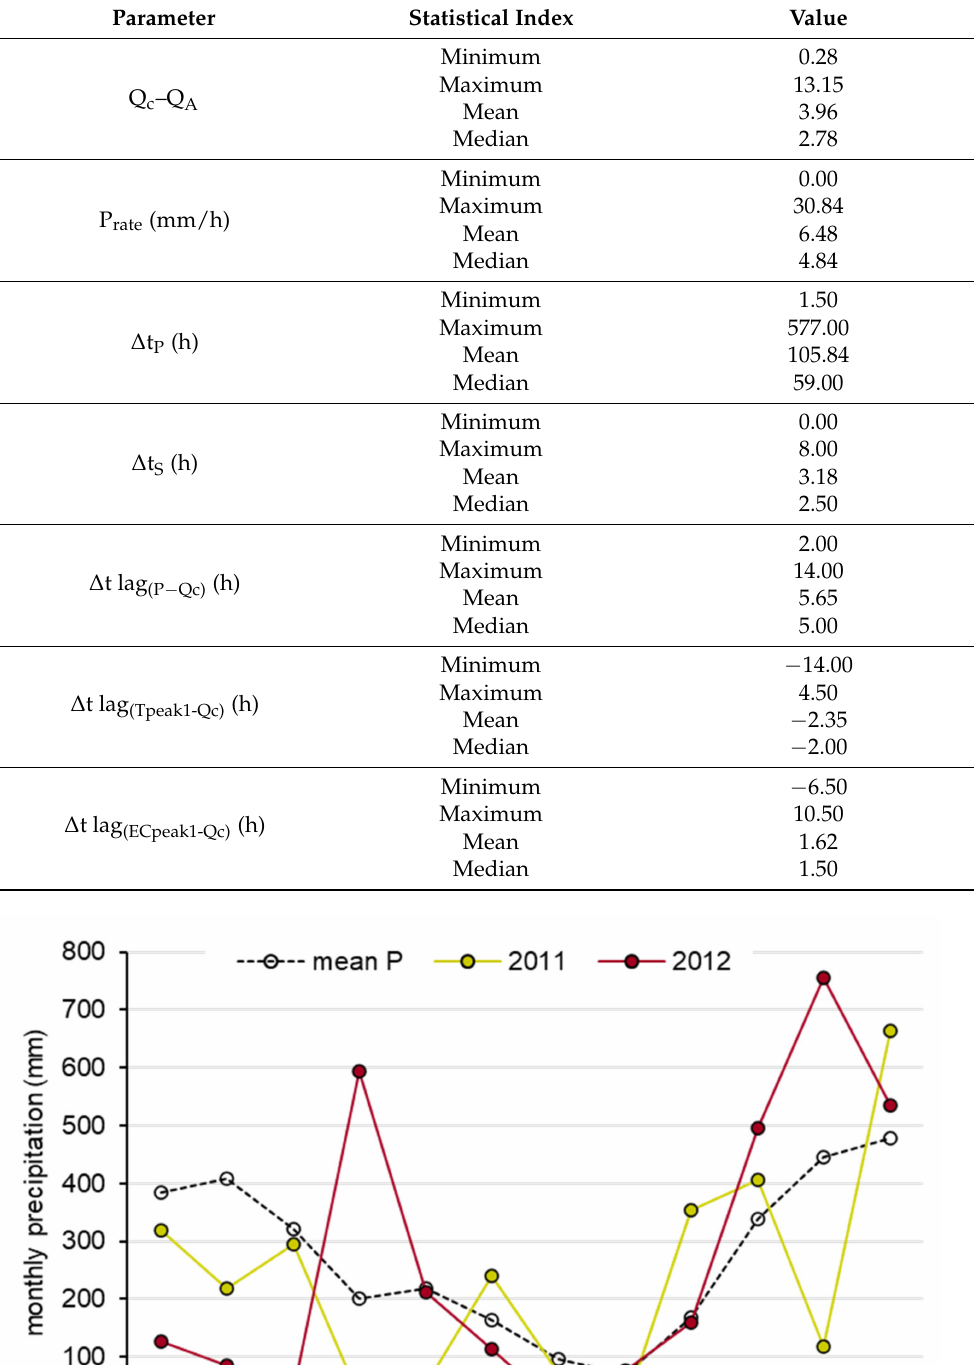
Table 2. Summary statistics of the main parameters of the storm HTC-graph analysis. More informa- tion on the analyzed storm HTC-graphs can be found in the Supplementary Materials (SM).